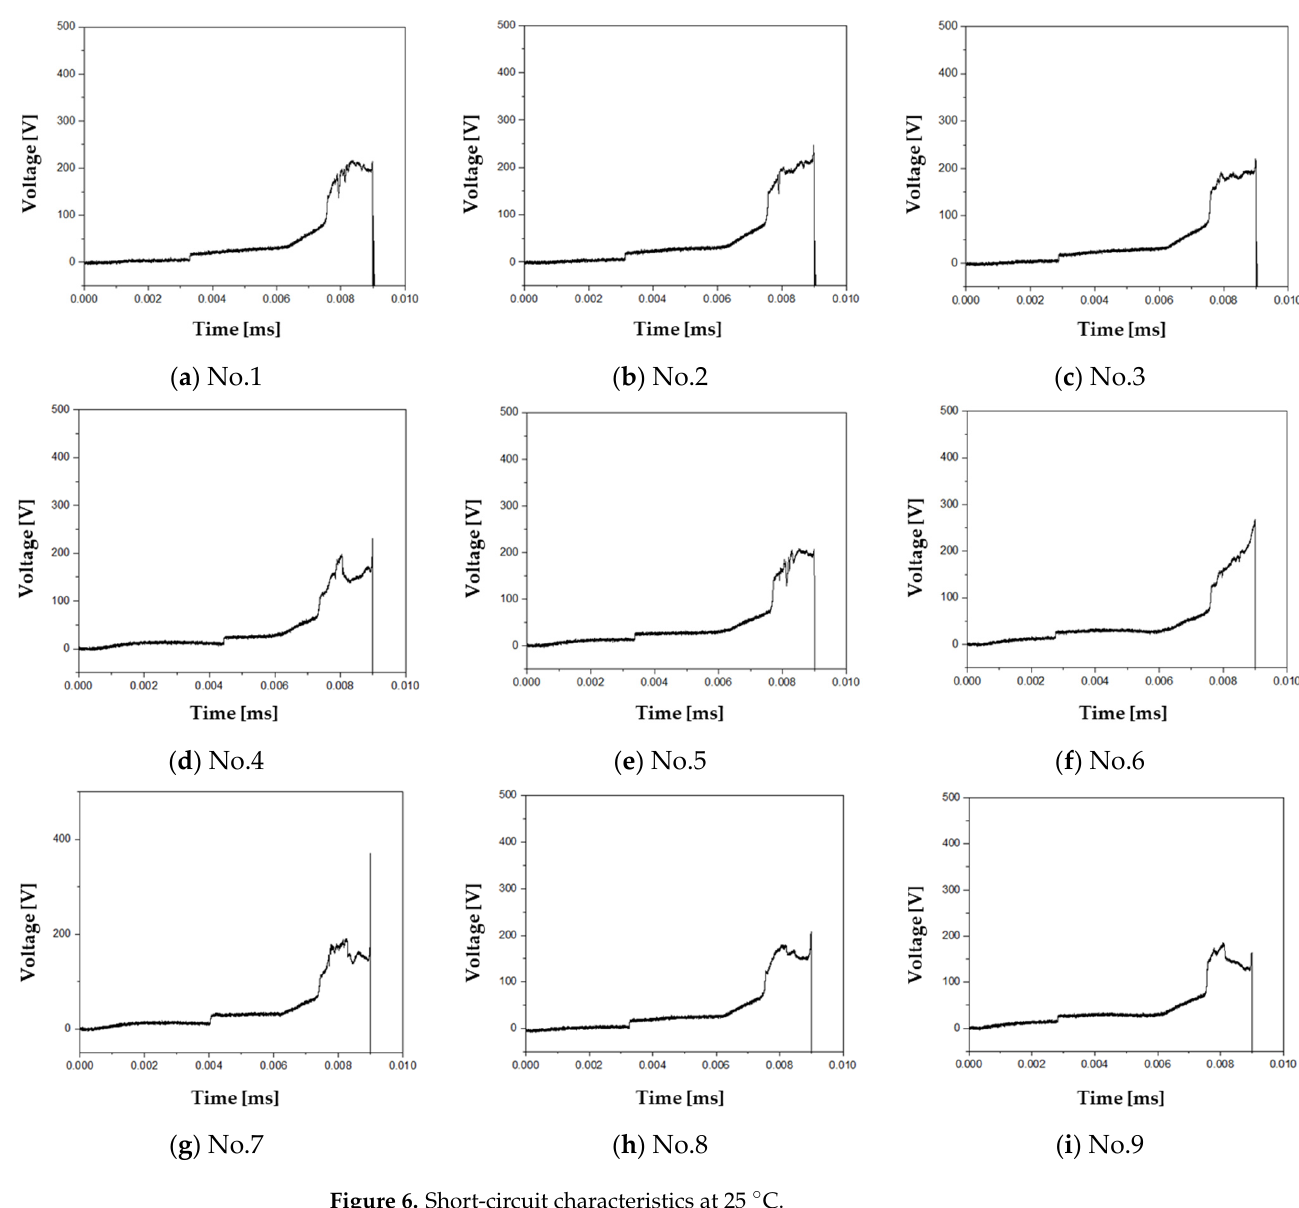
Figure 6. Short-circuit characteristics at 25 °C.